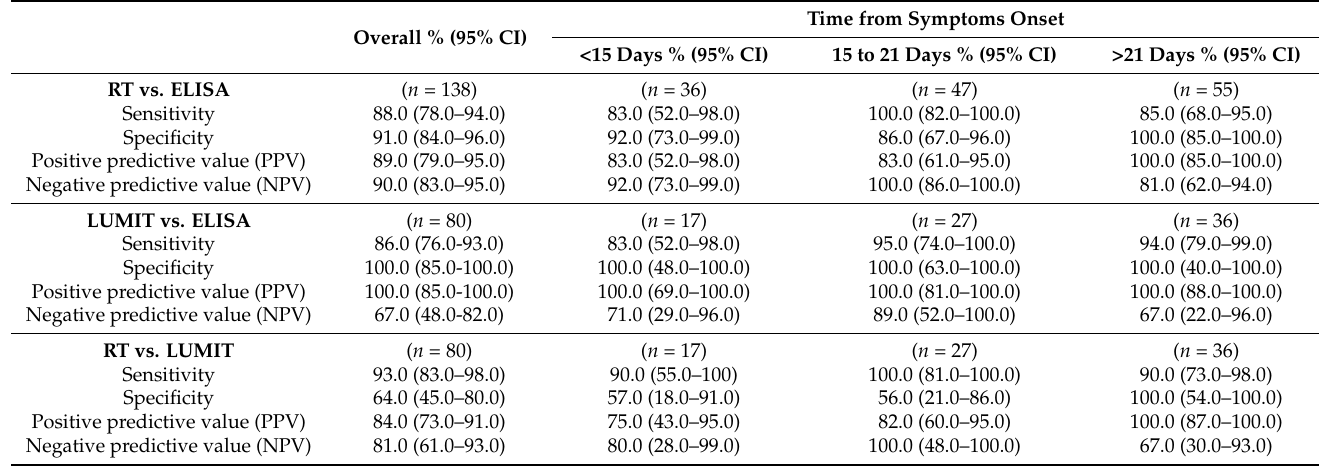
Table 3. Diagnostic performance of three immunoassays for detecting antibodies against SARS- CoV-2.